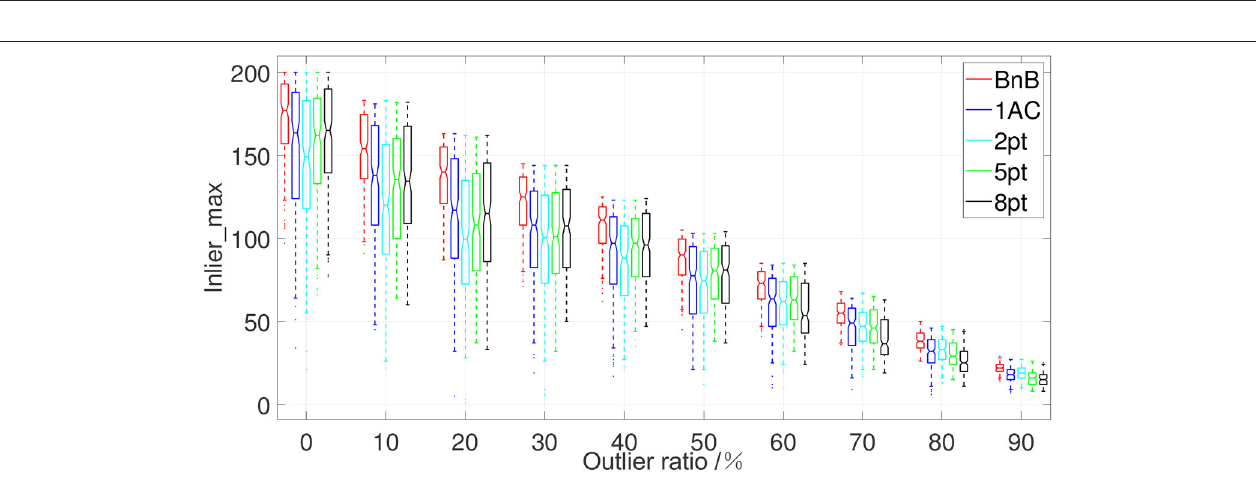
FIGURE 4 | The boxplot of inlier_max of five algorithms with respect to different ratios of outliers. The horizontal axis represents the ratio of manually added outliers and the vertical axis represents the performance of the inlier maximization of five algorithms. 1AC, 2pt, 5pt, and 8pt are the studies of Hartley and Zisserman (2003); Nistér (2004); Choi and Kim (2018); Guan et al. (2020), respectively, and BnB is our study.